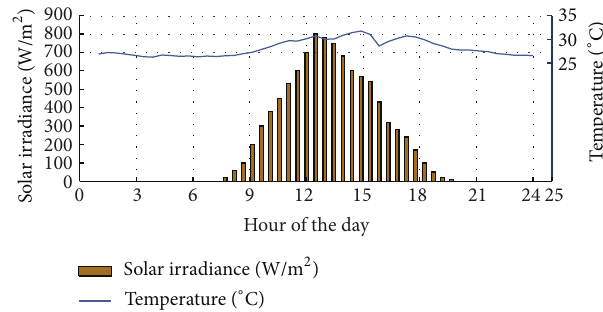
Table 4: Economic analysis parameters.